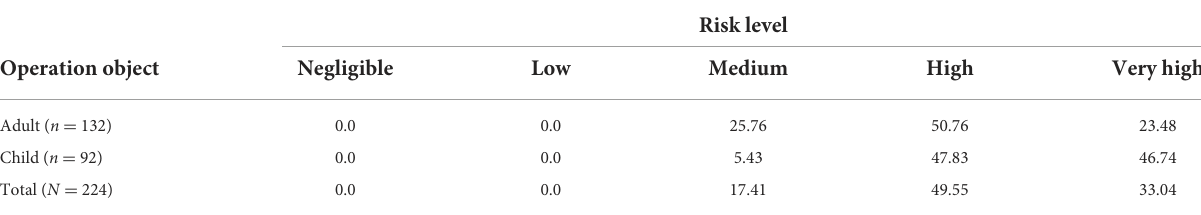
TABLE 2 Physiotherapy stratified by ergonomic risk level as determined by